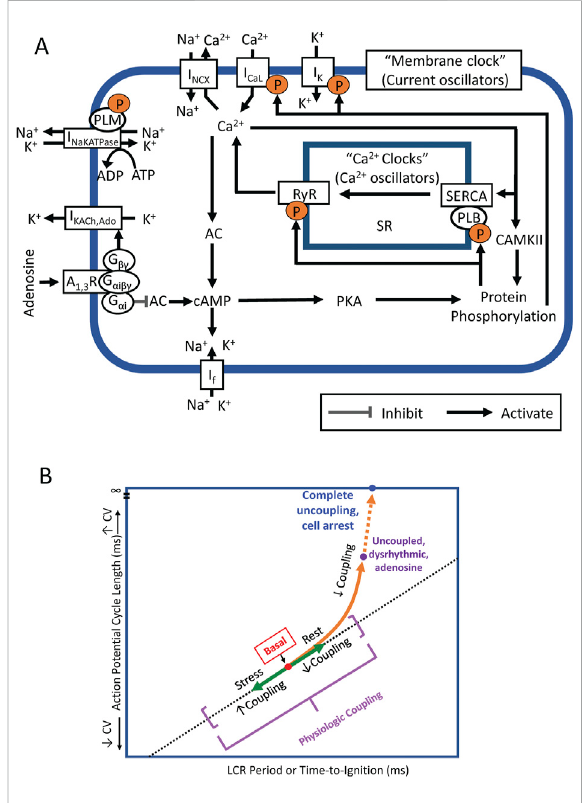
FIGURE 11 (A) Simpli fi ed schematic of the coupled system of membrane ioncurrentoscillatorsandCa 2+ oscillators(Coupled-clocksystem) operative within sinoatrial nodal cells (SANC). The system provides robust and fl exible AP fi ring rates. Constitutively active Ca 2+ - AC-cAMP-PKAsignalingintrinsictoSANC,thatisactivatedbyCa 2+ oscillations, couples to an ensemble of electrogenic surface membrane molecules (current oscillators). AC, adenylyl cyclase; cAMP, cyclic AMP; PKA, protein kinase A; A 1 R, adenosine A 1 receptor; G α i, Gi protein alpha subunit; G βγ , G i protein beta gamma subunit; RyR, ryanodine receptor; SERCA, sarco-endoplasmic reticulum Ca 2+ -ATPase; PLB, phospholamban; SR, Sarcoplasmic reticulum; CaMKII, Ca 2+ /calmodulin-dependent protein kinase II; I K ,delayedrecti fi erK + current;I KACh,Ado ,Acetylcholine/Adenosine- activated K + current; I f , HCN currents; I CaL , L-type Ca 2+ current; I NCX , Na + /Ca 2+ exchanger currents; and I NaKATPase , Na + /K + pump. (B) A schematic for SANC clock coupling/uncoupling. Clocks are coupled in the awake basal state, in response to physiologic stress (beta-adrenergic stimulation) coupling increases and beat-to-beat variability is reduced. In physiologic responses to vagal stimulation or adenosine, the clocks become partially uncoupled and the APCL becomes prolonged. These effects become more exaggerated as G i coupled stimulation increases at higher drug concentrations.